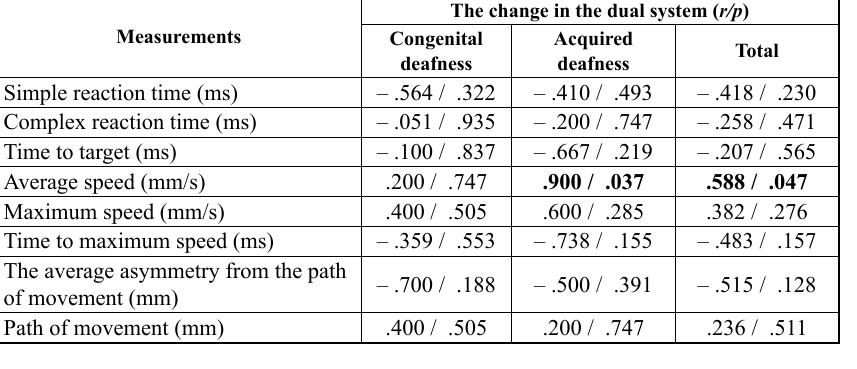
Figure 2. Links between the changes of the average reaction time and dual product for athletes with acquired deafness